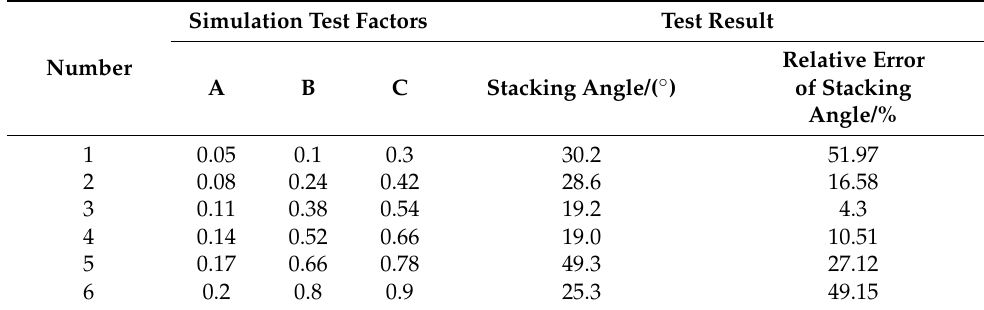
Table 5. Design and results of the steepest climbing test.